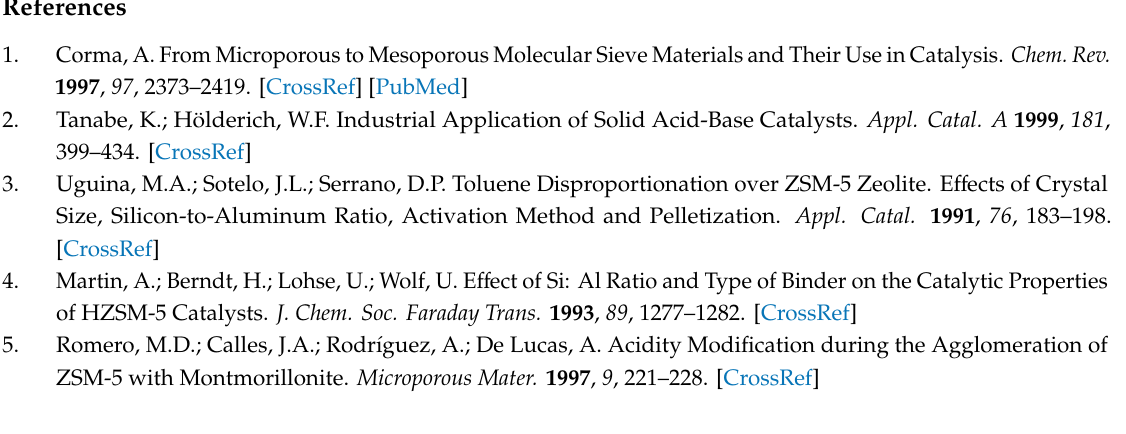
Figure S1: Pore size distribution of boeh_ext obtained by BJH method, Figure S2: SEM images of the samples with di ff erent quantities of PA1: ( a ) Catal_5PA1; ( b ) Catal_10PA1; ( c ) Catal_20PA1, Figure S3: Pore profile of the samples with di ff erent quantities of PA1 obtained by mercury intrusion porosimetry, Figure S4: Spectra of pyridine adsorption followed by FTIR after desorption at 150 ◦ C, Figure S5: Catalytic activity of boeh_ext: Conversion of methanol and selectivity in methane and dimethyl